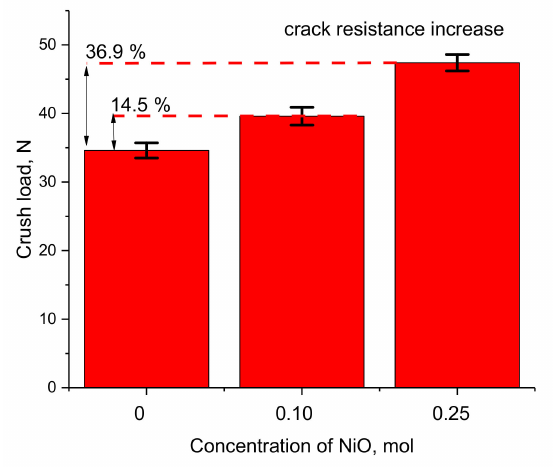
Figure 5. Diagram of the dependence of the change in the value of crack resistance on the concentra- tion of the dopant in the analysis of resistance to